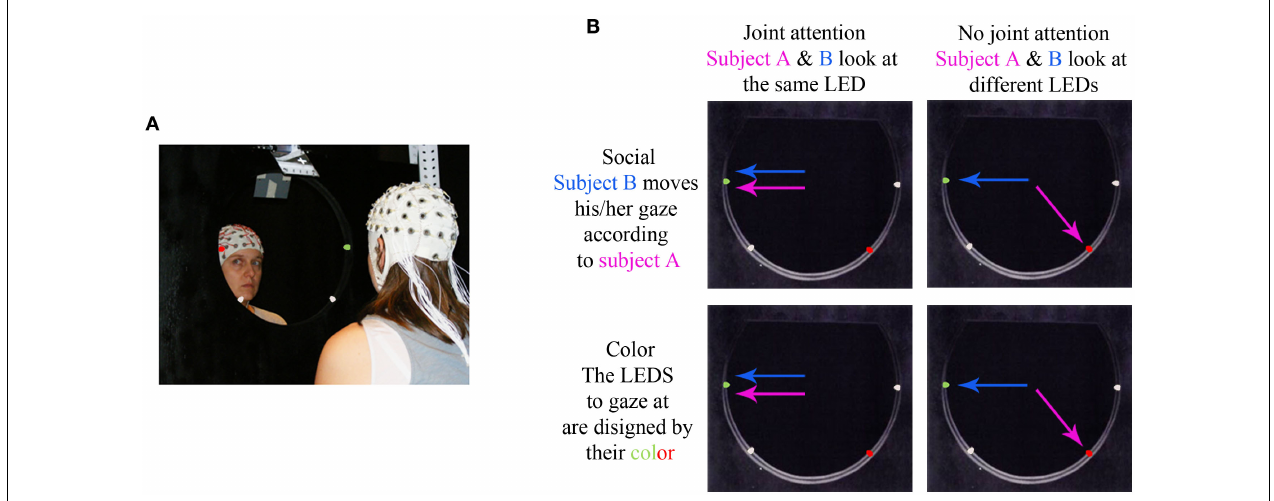
FIGURE 1 | Dual-EEG setup and experimental conditions. (A) Photograph of the device, with two LEDs turned on, and two participants facing each other. (B) The four experimental conditions are illustrated on a view of the device.The arrows represent the gaze direction of subject A (in pink) and subject B (in